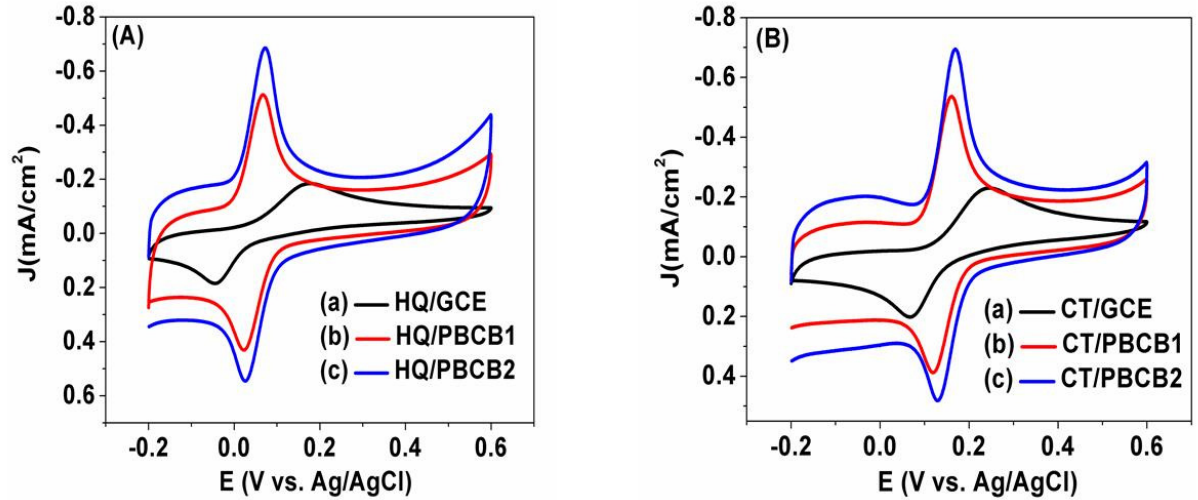
Figure 3. CVs of 0.50 mM HQ ( A ) and CT ( B ) in PBS (pH = 7.0) at GCE (a), PBCB1(b), and PBCB2 (c).